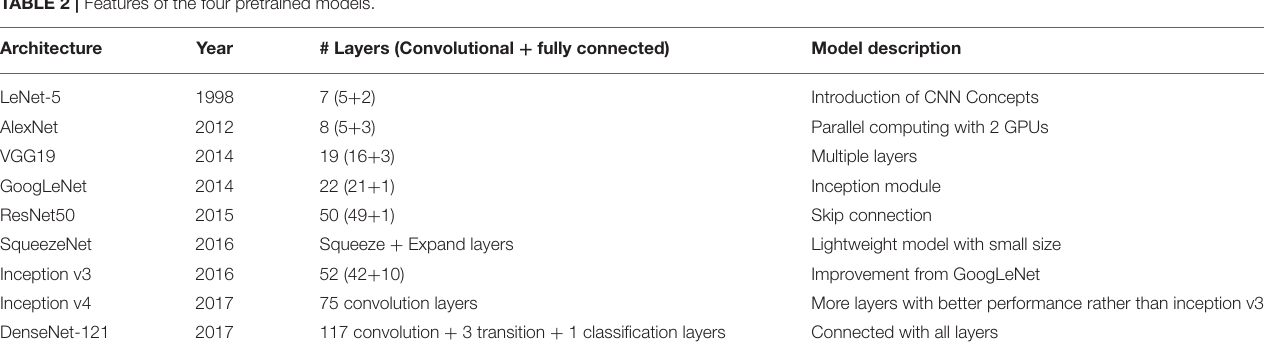
TABLE 2 | Features of the four pretrained models.